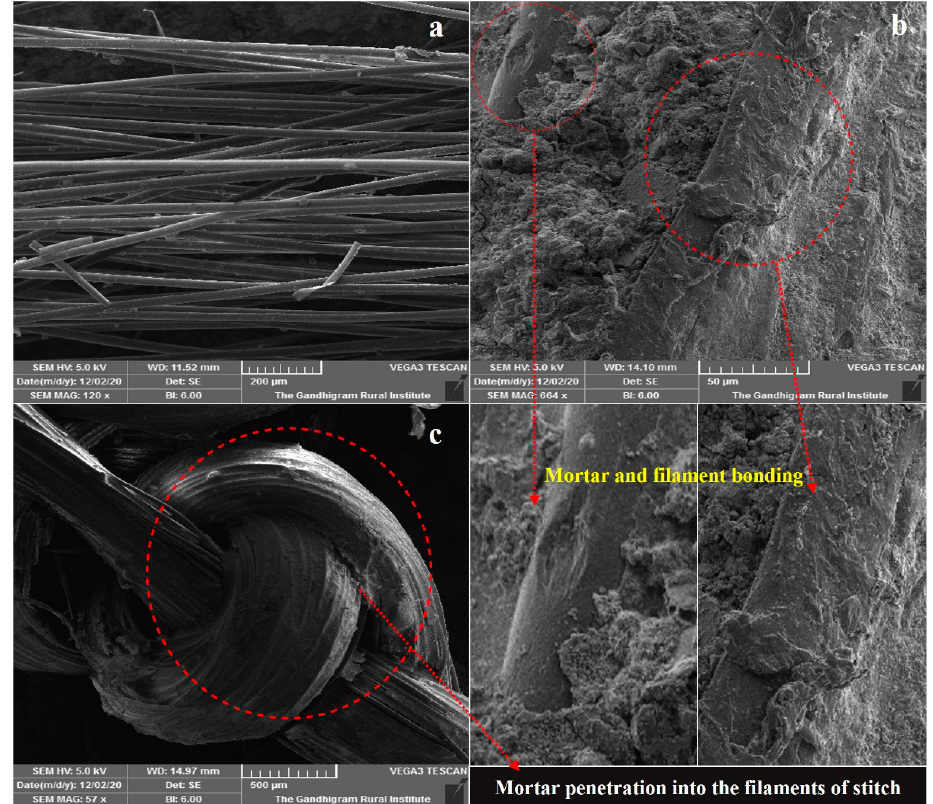
Figure 12. SEM images of ( a ) polypropylene filaments, ( b ) warp knitted fabric reinforced ferrocement composites, and ( c ) mortar penetration into the warp knitted fabric stitch. In Figure 12b, the bonding is clearly visible between the mortar mix and warp knit- ted fabrics. In Figure 12c, the penetration of mortar mix inside the warp knitted stitches of the filaments is clearly visible. As the curing days increases, the bond between mortar mix and warp knitted fabrics were increased due to the growth of microstructure. Thick mortar particles get patched to the fabric stitches leads to increase in strength. In big sandfly ferrocement composites, the mortar get tightly fixed between the diagonal strips postponed the first crack formation in flexure. 3.6. Statistical Data Analysis Flexural properties of polypropylene warp knitted reinforced ferrocement compo- sites were evaluated with statistical analysis of variance at 95% significance level with SAS system (version 8 for windows) for estimating the significance level of experimental variables on the flexural properties of the ferrocement composites. The p -values were calculated to analyze whether there is a significant improvement in the flexural proper- ties with the polypropylene warp knitted reinforcement. The statistical values are given in Tables 6–8. It is evident that there is a significant difference is there in the first crack load and ultimate load between the control sample and pp reinforced ferrocement com- posites. Also it is noted that the energy absorption factor and ductility factor doesn’t show any significant difference in the statistical analysis. This is due to the lesser deflec- tion of polypropylene warp knitted reinforced ferrocement composites which are already proved previously in an experiment [52].